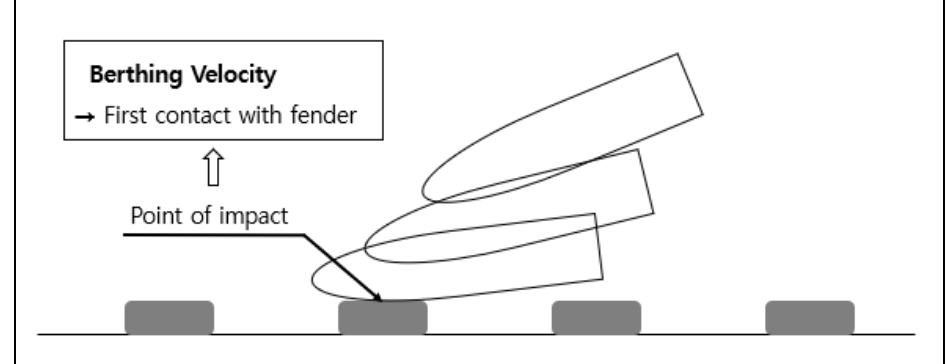
Figure 3. Conceptual diagram of the berthing velocity .